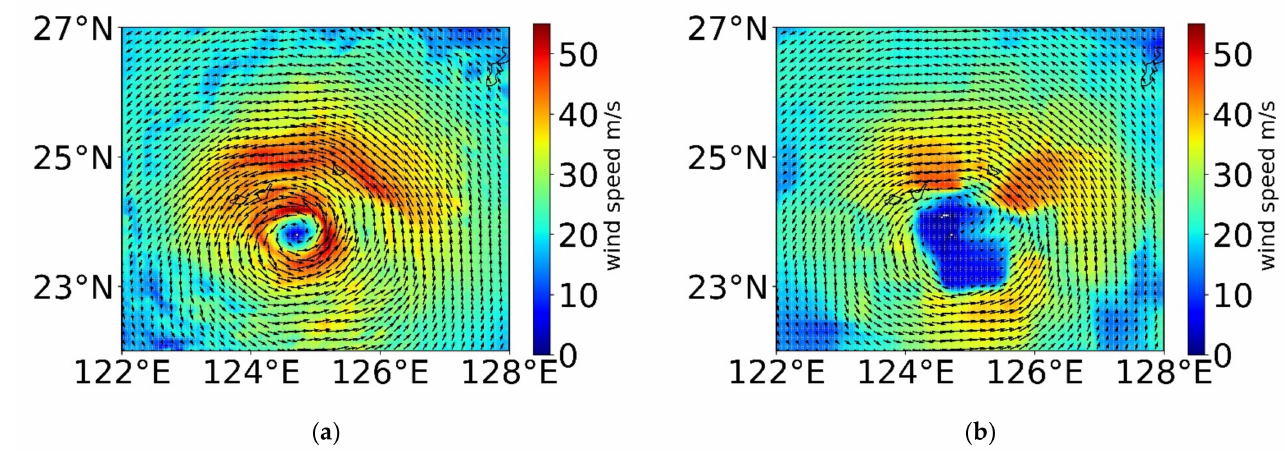
Figure 9. WRF wind field ( a ) and OF wind field ( b ) at 400 hPa of the typhoon area with the 5 min revisiting time.